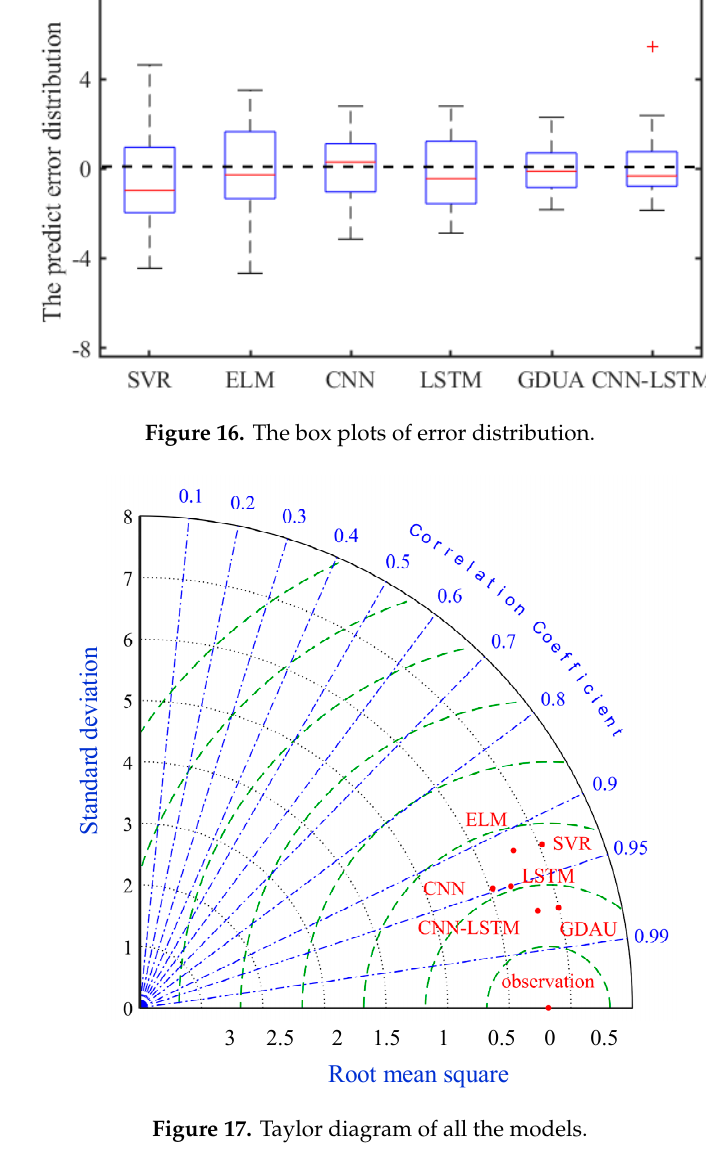
Figure 17. Taylor diagram of all the models.